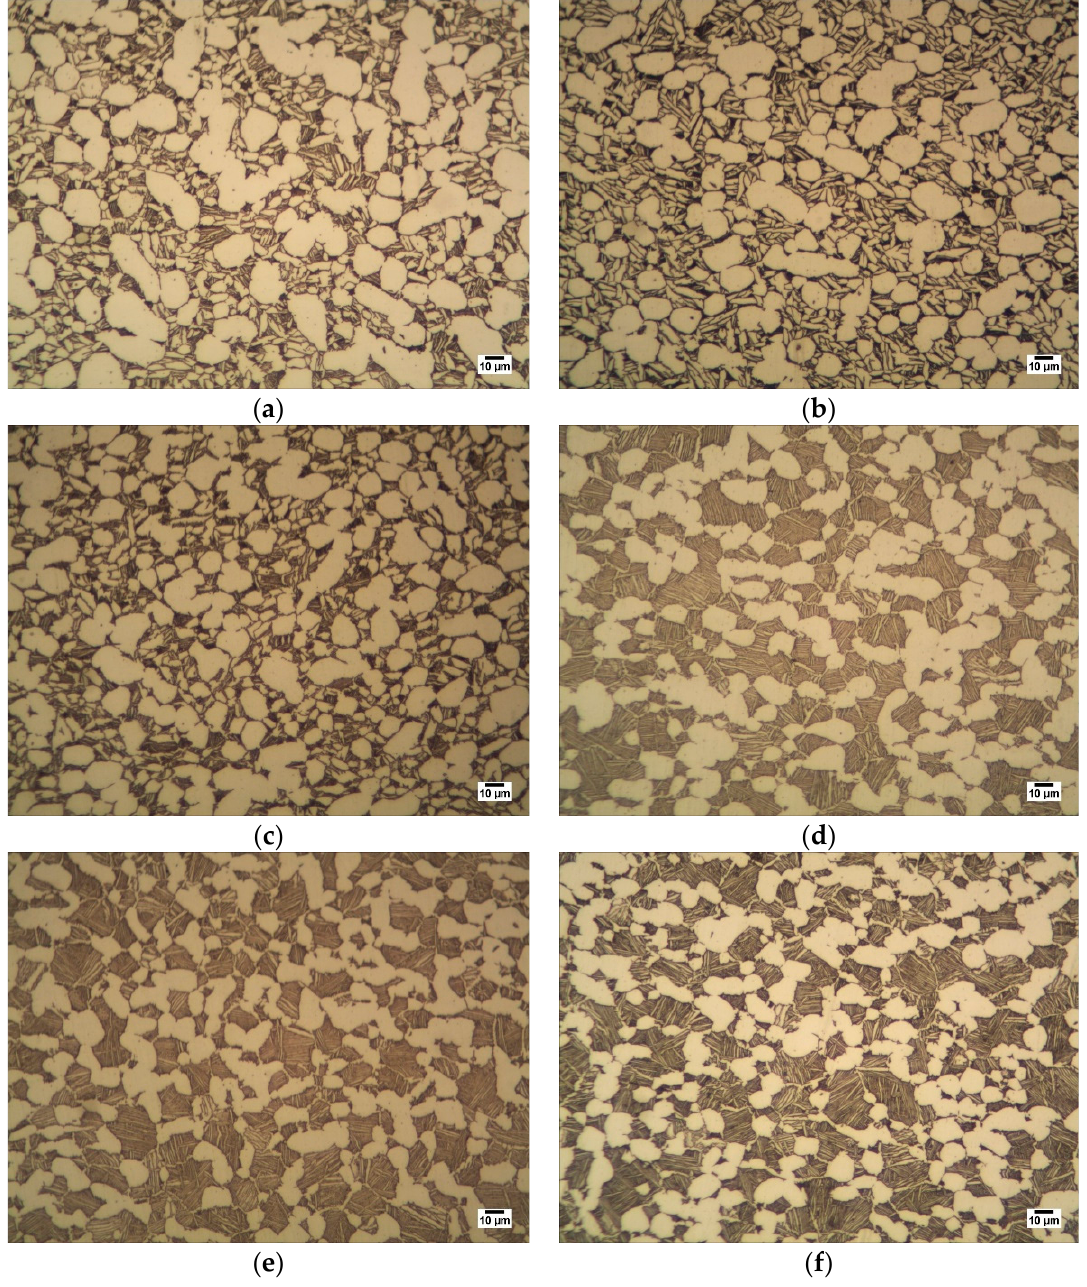
Figure 3. Typical metallographic diagram of ring structure: ( a ) G-1, ( b ) G-2, ( c ) G-3, ( d ) X-1, ( e ) X-2, ( f ) X-3. Table 1. Partial original data of TC25